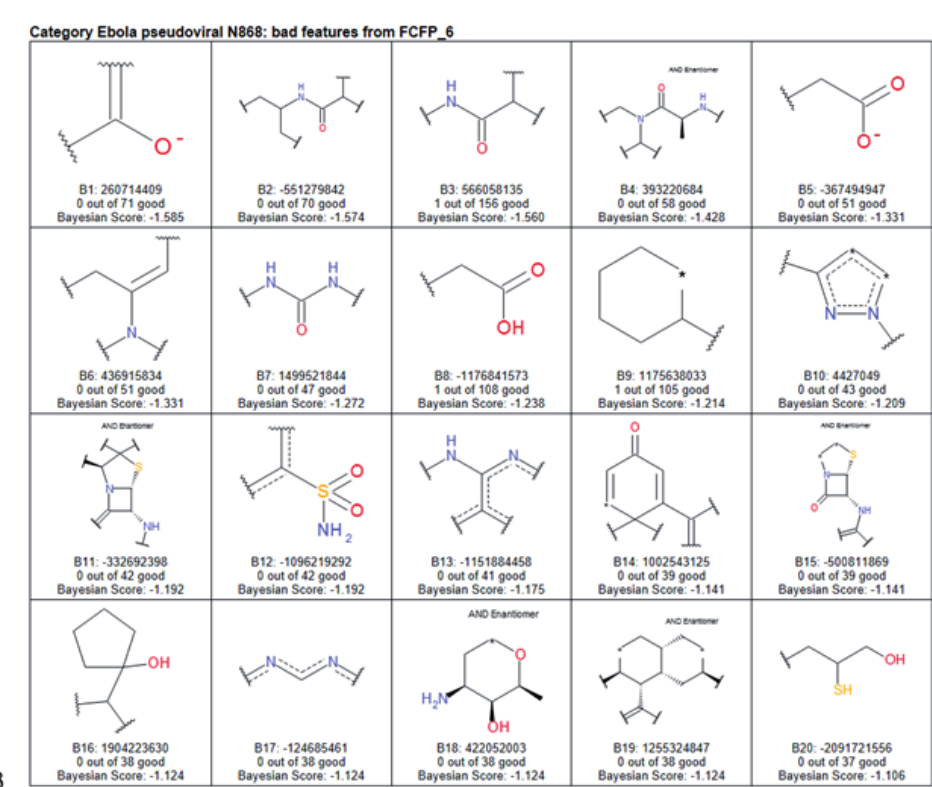
Figure 1. A . Active and B . Inactive features for the Discovery Studio pseudotype Bayesian